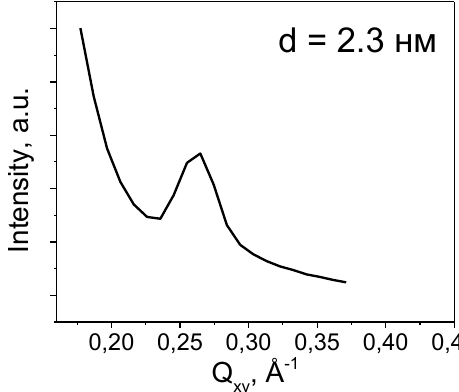
Fig. 4. GID curve of the floating layer of compound II.